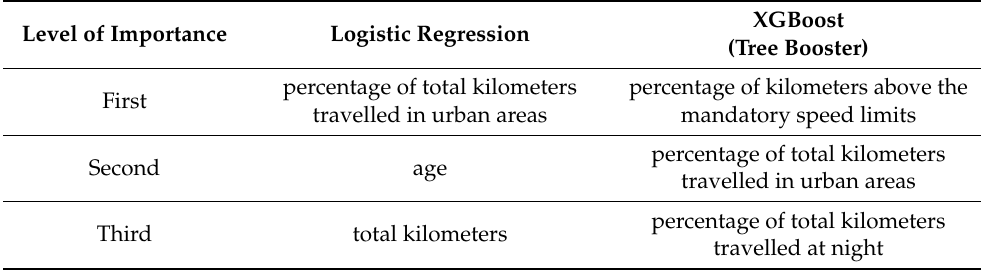
Table 4. Variable Importance. The most relevant variables of the di ff erent